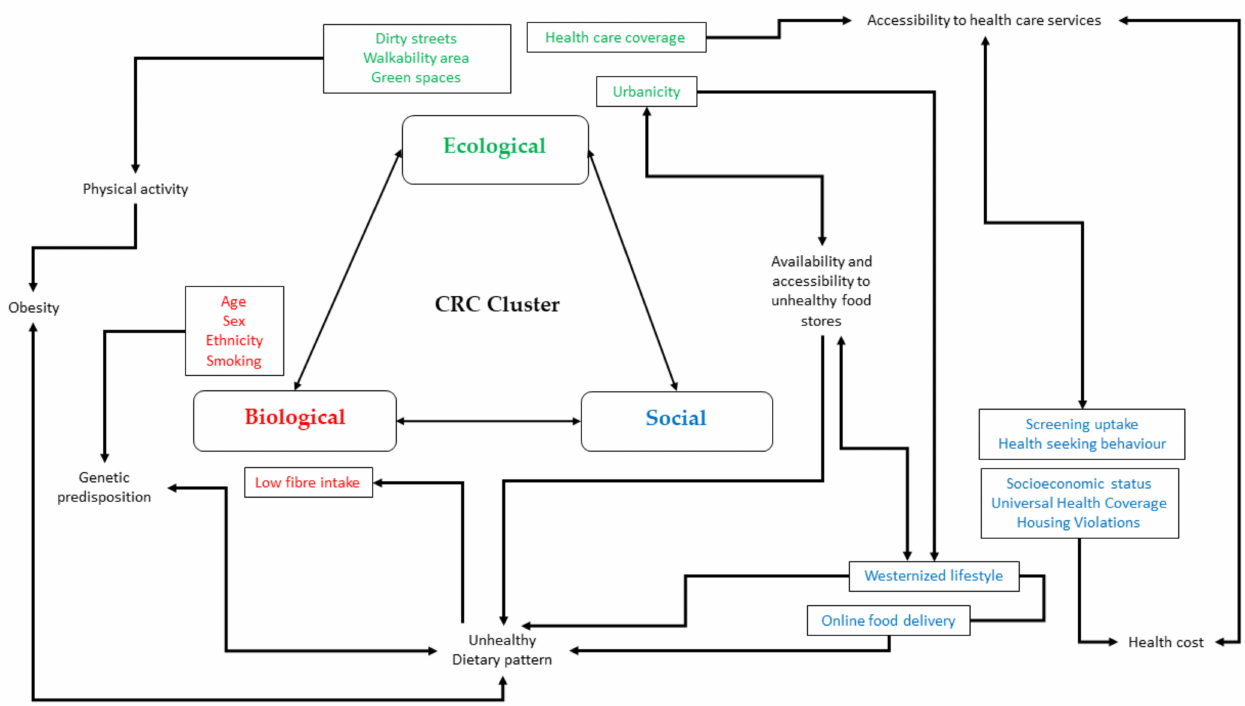
Figure 3. Conceptualization of interaction between ecological, biological, and social determinants influence formation of CRC